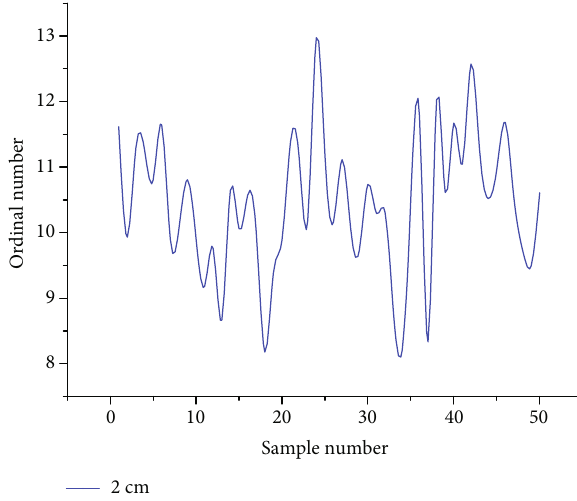
Figure 6: Identi fi cation coe ffi cient with defect thickness of 1 cm. Figure